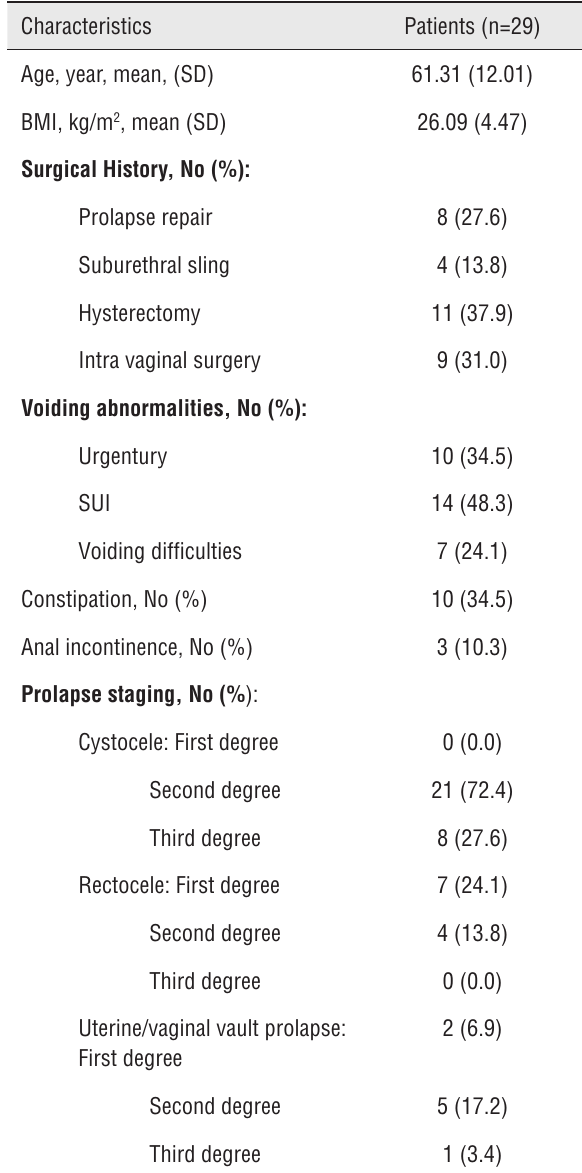
Table 1 – Patients characteristics.